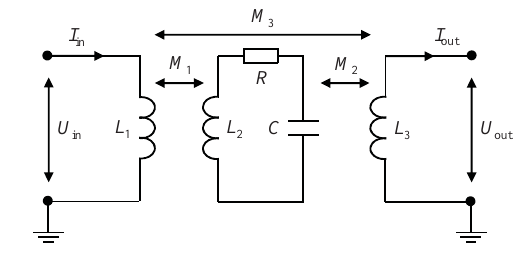
Figure 6: RLC resonance circuit.